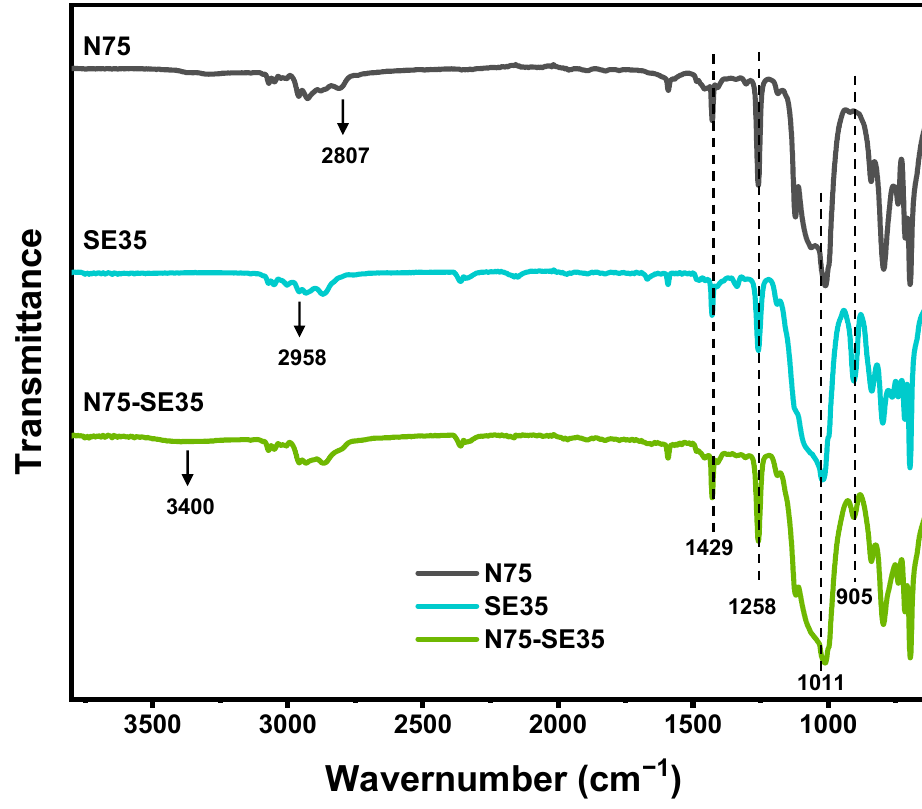
Figure 5. The FT-IR spectra of N75, SE35, and N75-SE35.